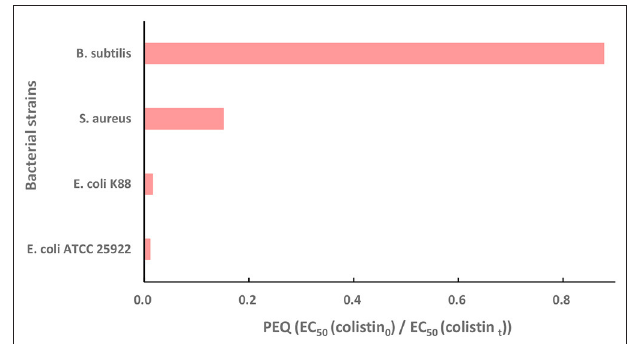
FIGURE 4 | The potency equivalent quotient (PEQ) of colistin against E. coli ATCC 25922, wild type strain E. coli K88, S. aureus and B. subtilis . Initial colistin concentration, 30 µ M; [Fe(VI)]/(colistin) molar ratio, 30; initial pH, 7.0; temperature, 25 ◦ C, reaction duration, 60min. PEQ = EC 50 (colistin 0 )/EC 50 (colistin t ) where colistin 0 and colistin t represent colistin before and after Fe (VI) treatment.